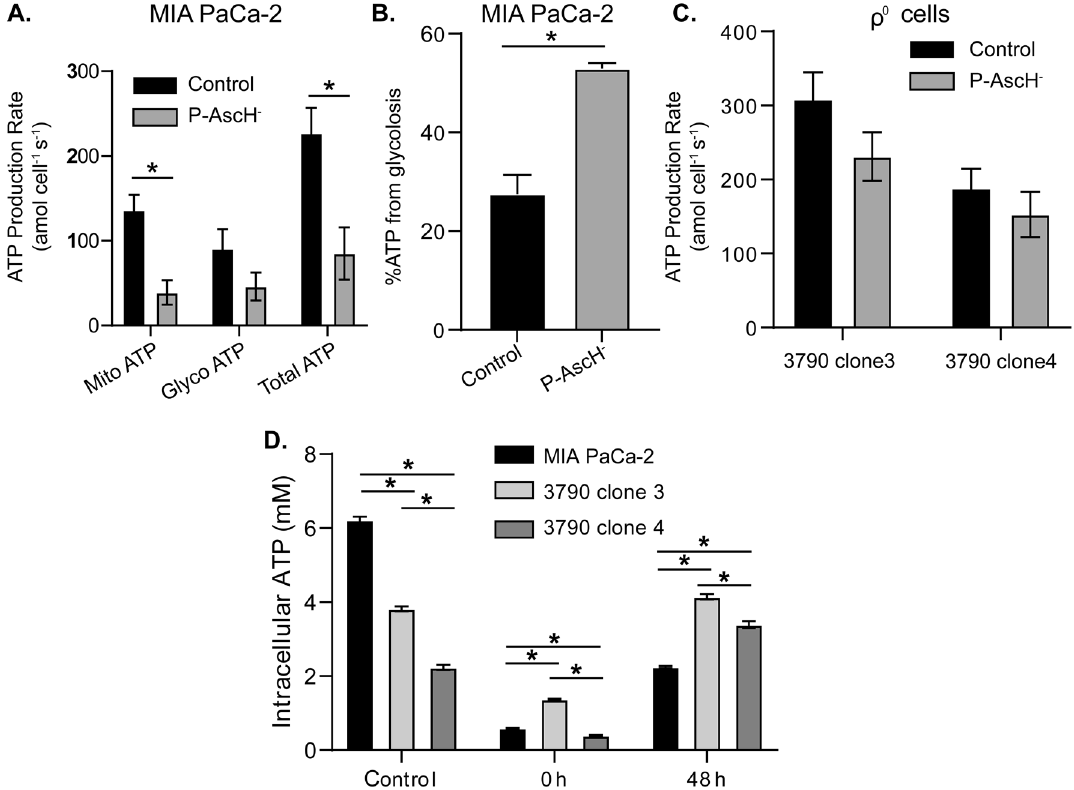
Figure 4. Changes in ATP in MIA PaCa-2 and ρ 0 cells following treatment with P-AscH - . MIA PaCa-2 and ρ 0 clones were exposed to P-AscH - (7 pmol cell −1 for 1 h) and the rates of production of glycolytic ATP, mitochondrial ATP, and total ATP were measured 48 h later. Rates are normalized to cell number and expressed as amol cell −1 s −141 . ( A ) Rates of production ATP from mitochondria and total ATP of MIA PaCa-2 cells were decreased 48 h after exposure to P-AscH - while glycolytic ATP production was less effected ( n = 3, mean ± SEM; * p < 0.05, unpaired t-test). ( B ) The percent contribution of glycolysis to the production of ATP in MIA PACa-2 cells increased after exposure to P-AscH - ( n = 3, mean ± SEM; * p < 0.05, unpaired t test). ( C ) Compared to the significant decrease in the rate of production of ATP seen in panel A, the rate of production of ATP in ρ 0 cells (3790 clone 3, 3790 clone 4) did not change significantly ( n = 3, mean ± SEM). ( D ) Steady-state levels of intracellular ATP of MIA PaCa-2 and ρ 0 cells decreased significantly after P-AscH - . There was a significant decrease in ATP levels in MIA PaCa-2 cells compared to the ρ 0 cells at 1 h after exposure P-AscH - ( n = 3, mean ± SEM, * p < 0.05, one-way ANOVA Tukey’s multiple comparison test). At 48 h, intracellular ATP levels are significantly increased in ρ 0 cells compared to MIA PaCa-2 cells ( n = 3, mean ± SEM, * p < 0.05, one-way ANOVA Tukey’s multiple comparison